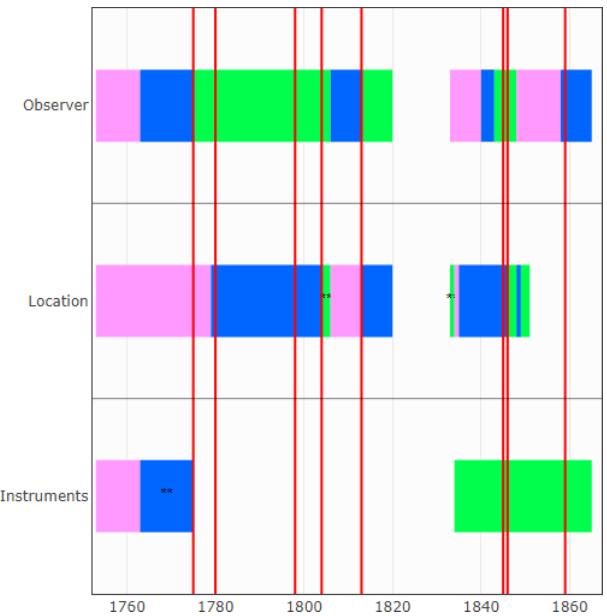
Figure A2. Station history and ACMANT-detected breaks, 1753– 1870. Sources: Tidblom (1876), Schalén et al. (1968), and Bärring et al. (1999). Note: each colored area represents a distinct period lo- cation, observer, or set of instruments. ∗∗ denotes multiple changes during the indicated period. Detected breaks are shown by the ver- tical red lines. Gaps in white signify missing